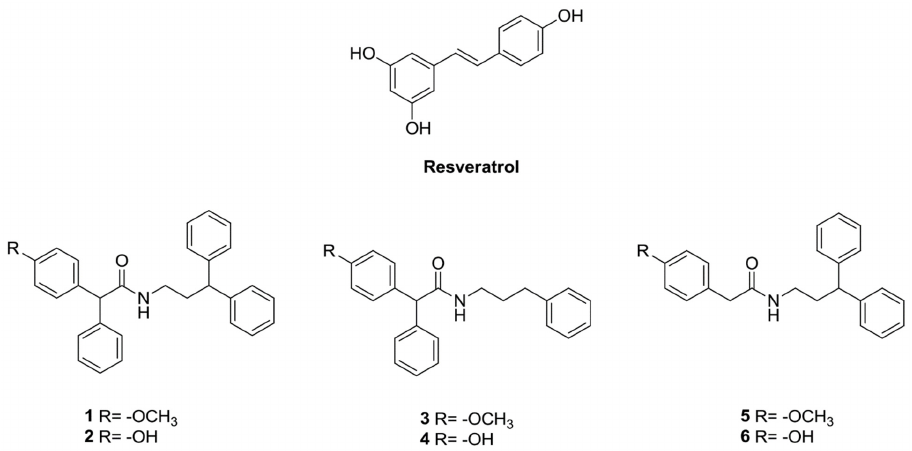
Figure 1. Molecular structure of RSV and the tested RSV derivatives ( 1 – 6 ).